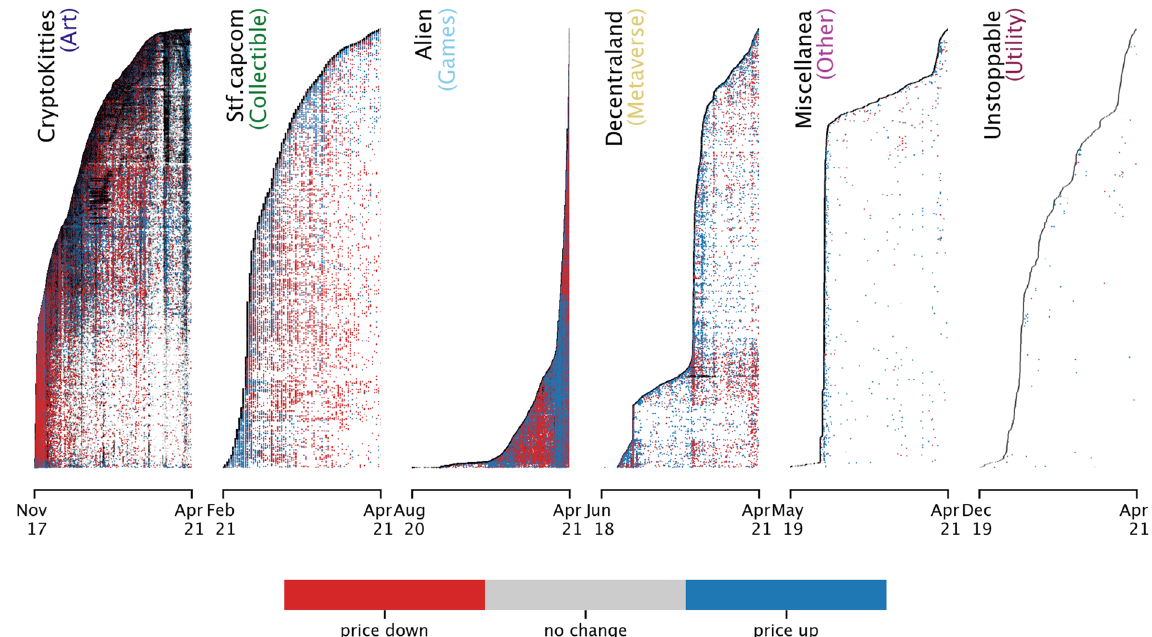
Figure 3. Secondary sale prices. Sales over time for the top collection in terms of number of sales in each NFT category (CryptoKitties, Stf.capcorn, Alien, Decentraland, Miscellanea, and Unstoppable). Each horizontal line represents an NFT and each dot a sale. Sales are coloured based on the change in price compared to previous sale (see